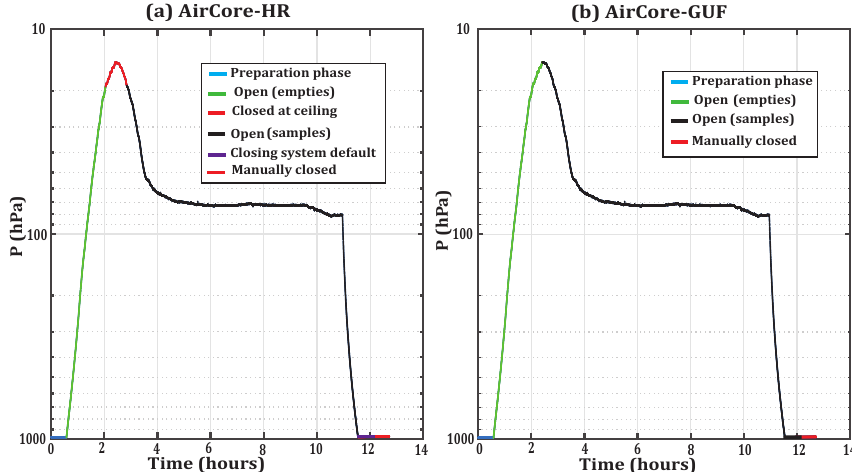
Figure 6. Flight plan from the StratoScience 2014 EdS-Stratéole flight on 29 August 2014 with main operating states of (a) AirCore-HR and (b) AirCore-GUF: the preparation phase, on the ground before flight (blue), ascent phase (green), descent phase (black) and closed (red).